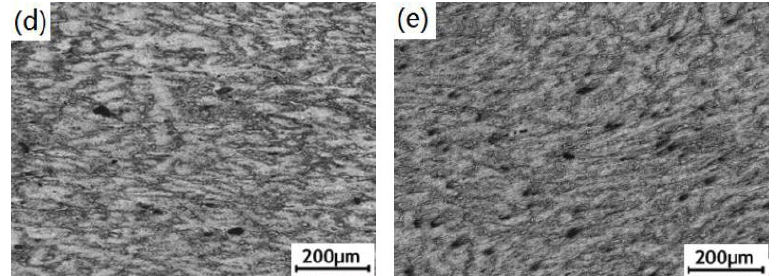
Figure 1. Micrographs of the AZ91D alloy before and after multi-pass equal-channel angular pressing: ( a ) as-cast; ( b ) 4 passes; ( c ) 8 passes; ( d ) 12 passes and ( e ) 16 passes.